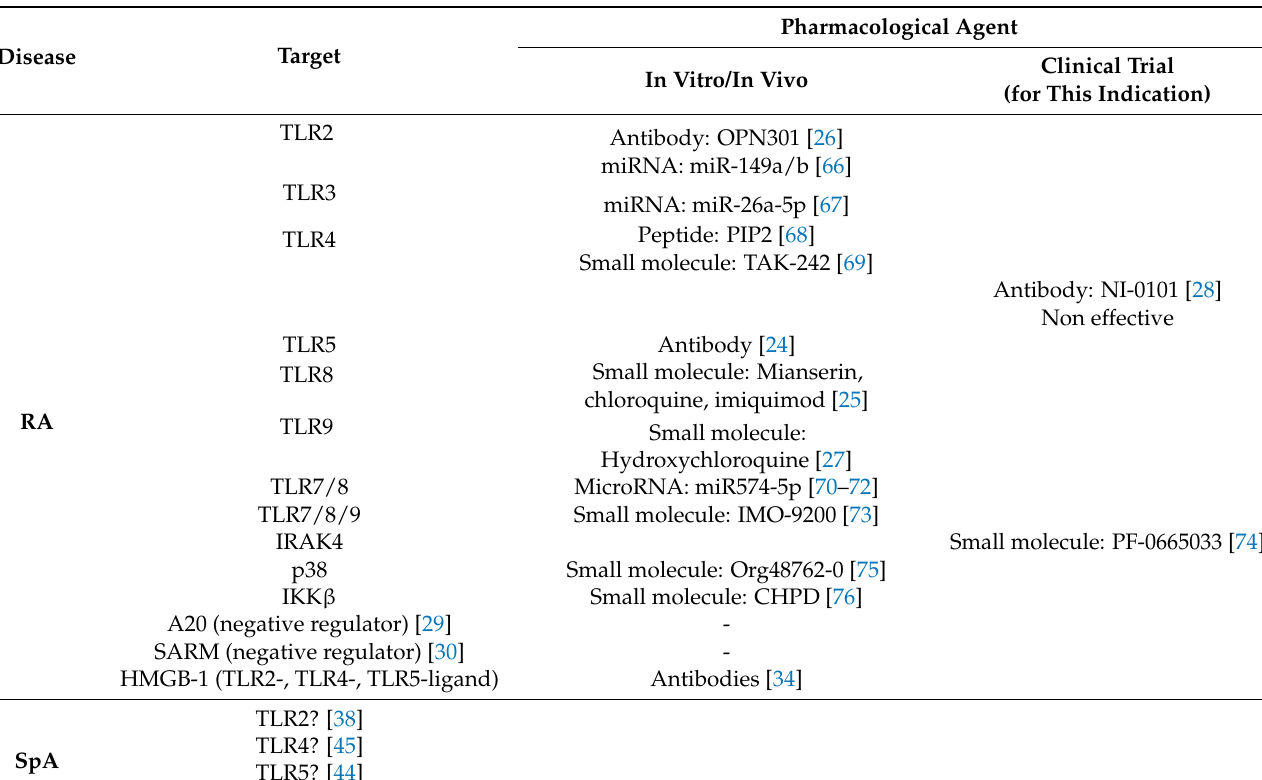
Table 1. TLR inhibitors used in inflammatory arthritis.